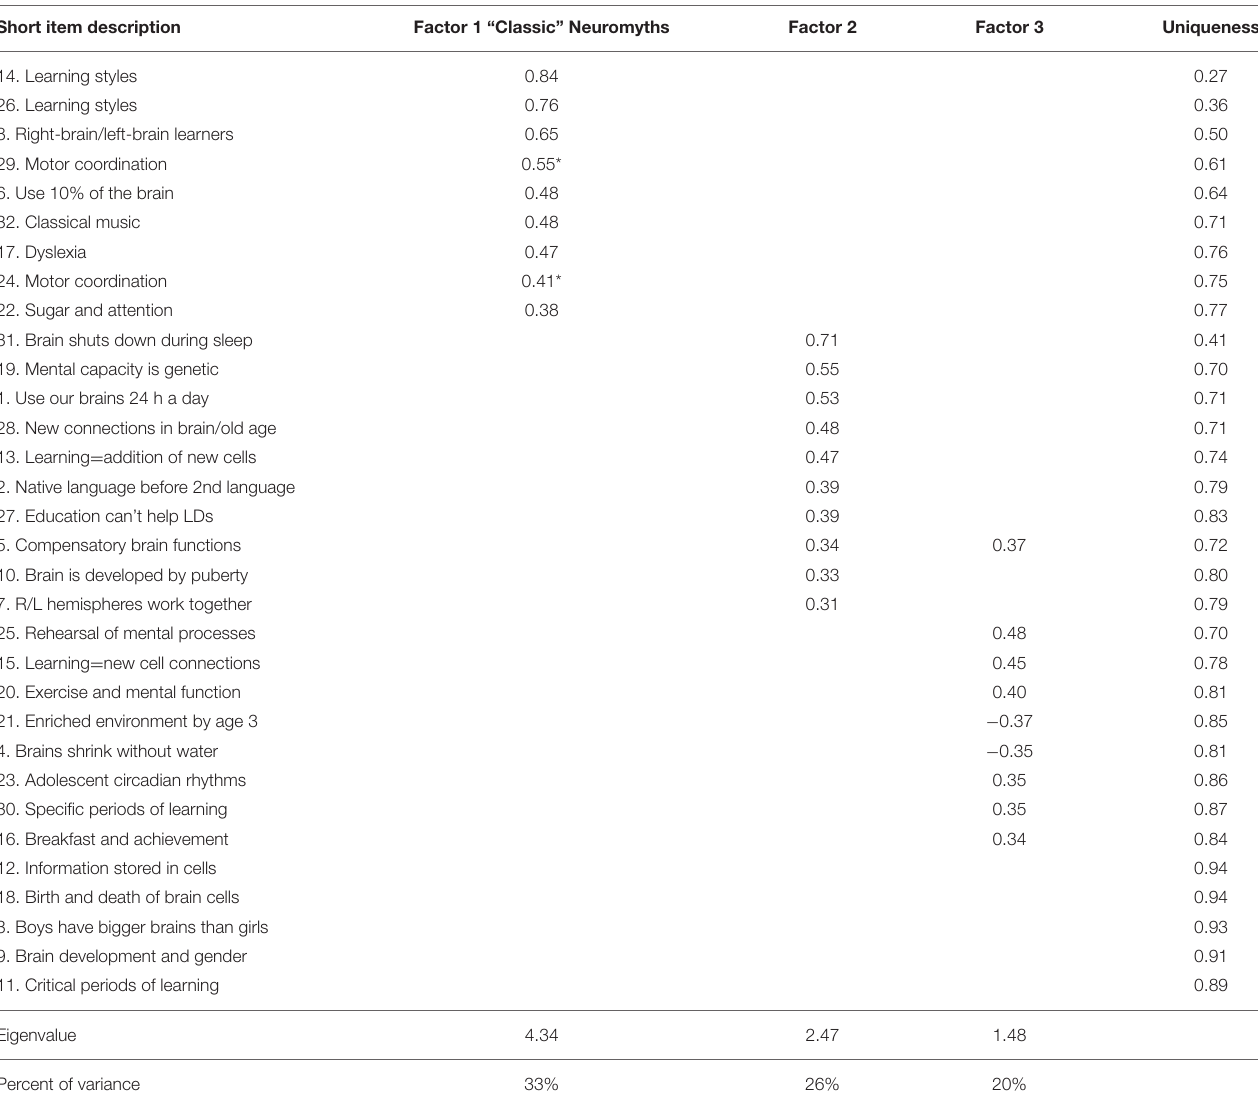
TABLE 4 | Results from exploratory factor